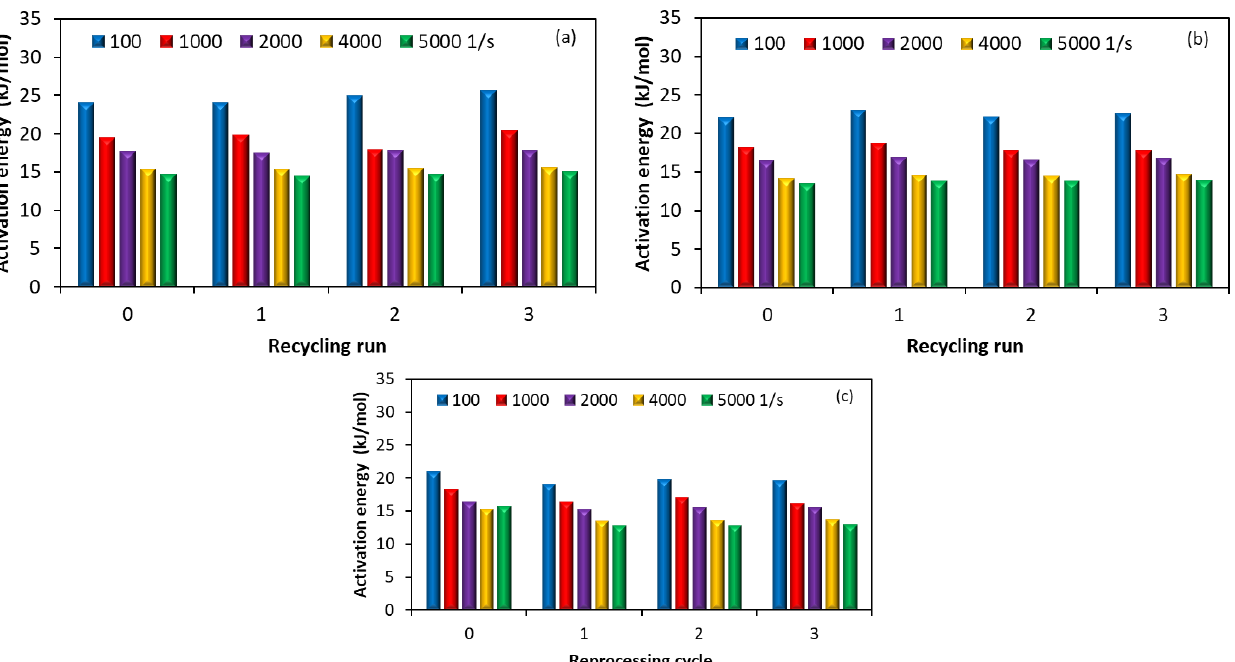
Figure 9. Influence of reprocessing on shear stress as a function of shear rate for the composites with ( a ) 1 wt.%, ( b ) 3 wt.% and ( c ) 5 wt.% of MWCNTs.